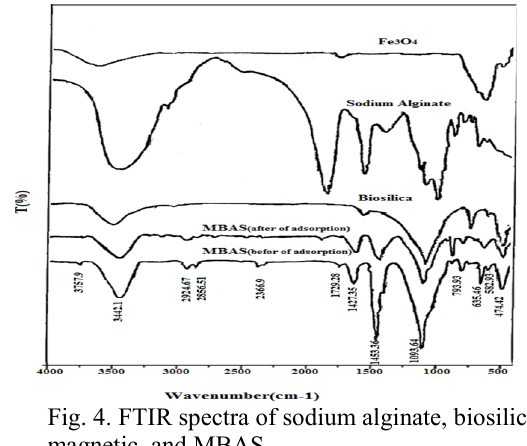
Fig. 4. FTIR spectra of sodium alginate, biosilica, magnetic, and